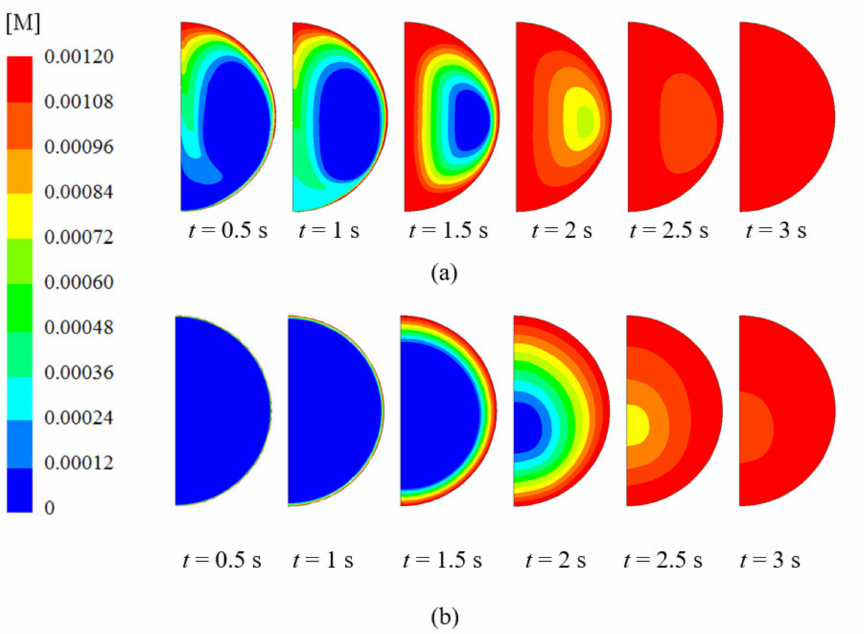
Figure 10. Concentration of CO 2 against time (t); ( a ) 1000 µ m initial diameter; ( b ) 500 µ m ini- tial diameter. 5% initial ammonia concentration, 100 ◦ C initial gas temperature, and 5 ◦ C initial liquid temperature.